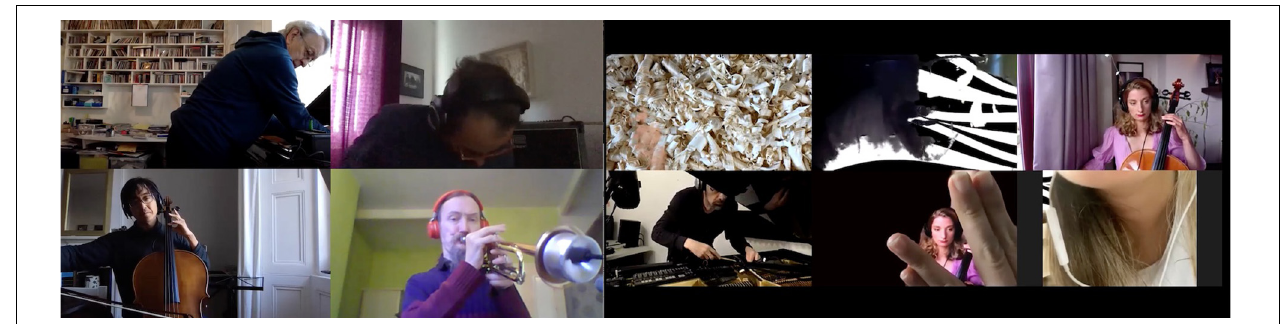
FIGURE 6 | Comparison atmospheres.